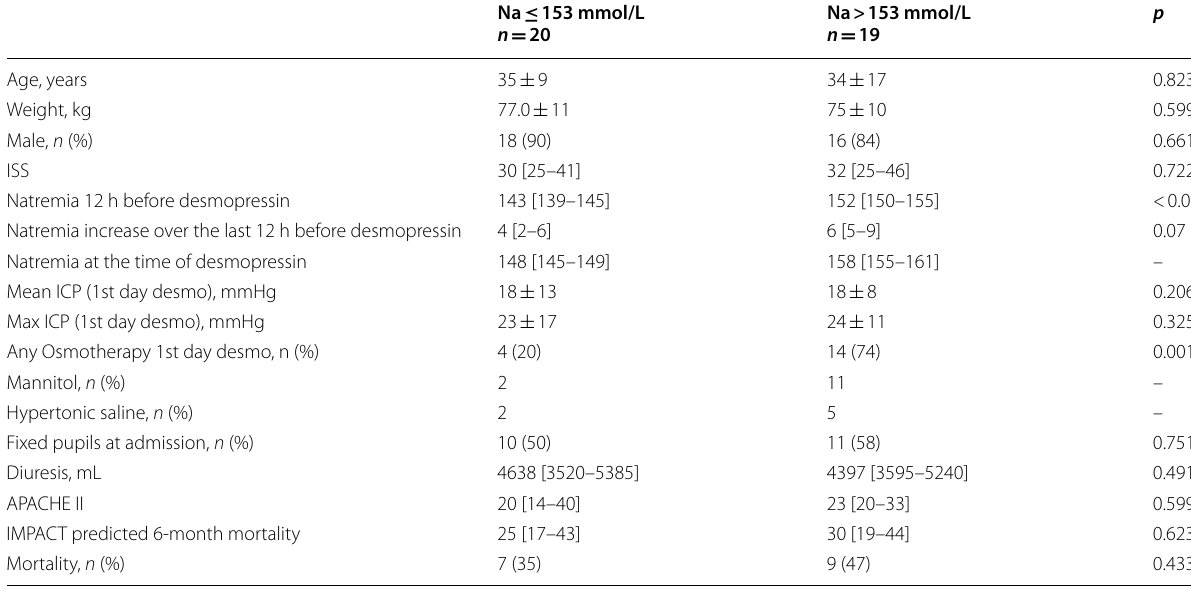
Table 3 Characteristics of patients according to the severity of hypernatremia at the time of desmopressin